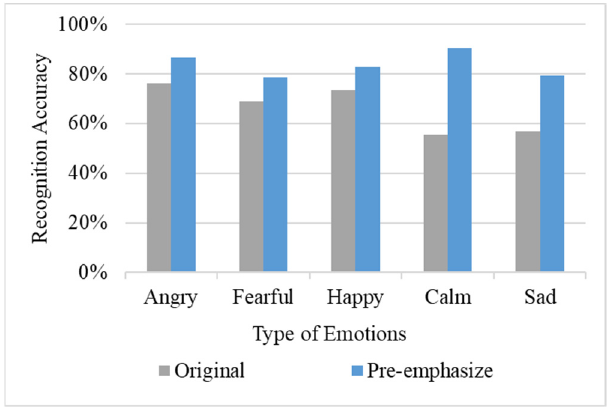
Figure 10. Results of the pre-emphasize procedure. Table 1. Comparison of original method and pre-emphasized results.